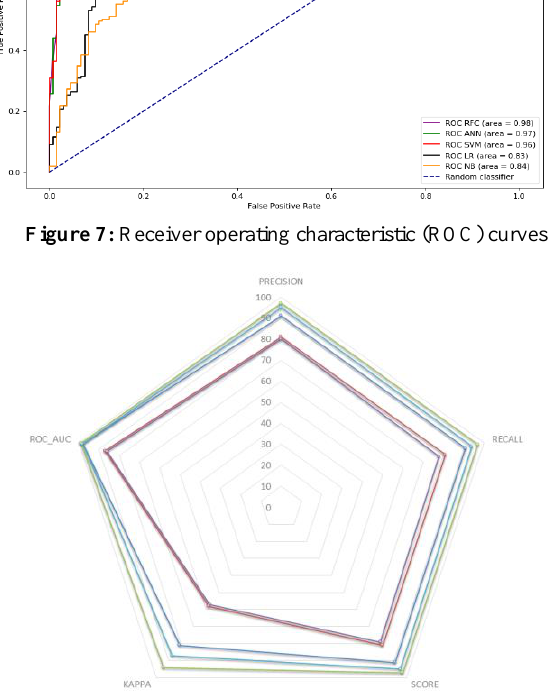
Figure 8 : A comparison of precision, recall, score, Kappa and ROC for the FF susceptibility using SVM , LR , RF , NB and